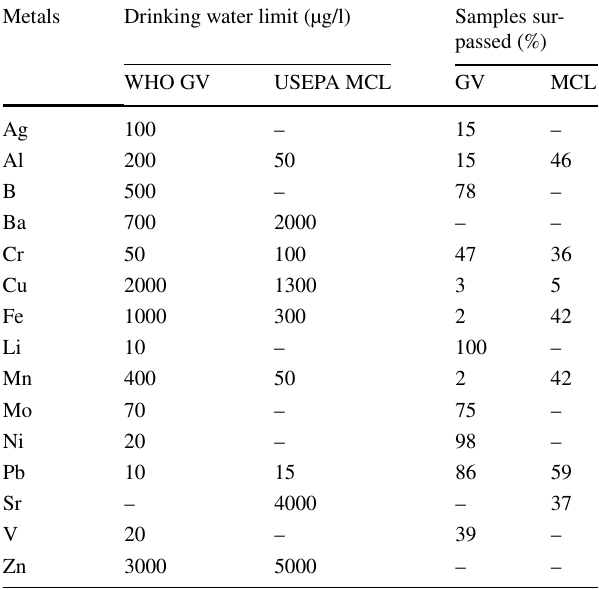
Table 3 Metals contamination status in groundwater and water usa- bility assessment using WHO and USEPA